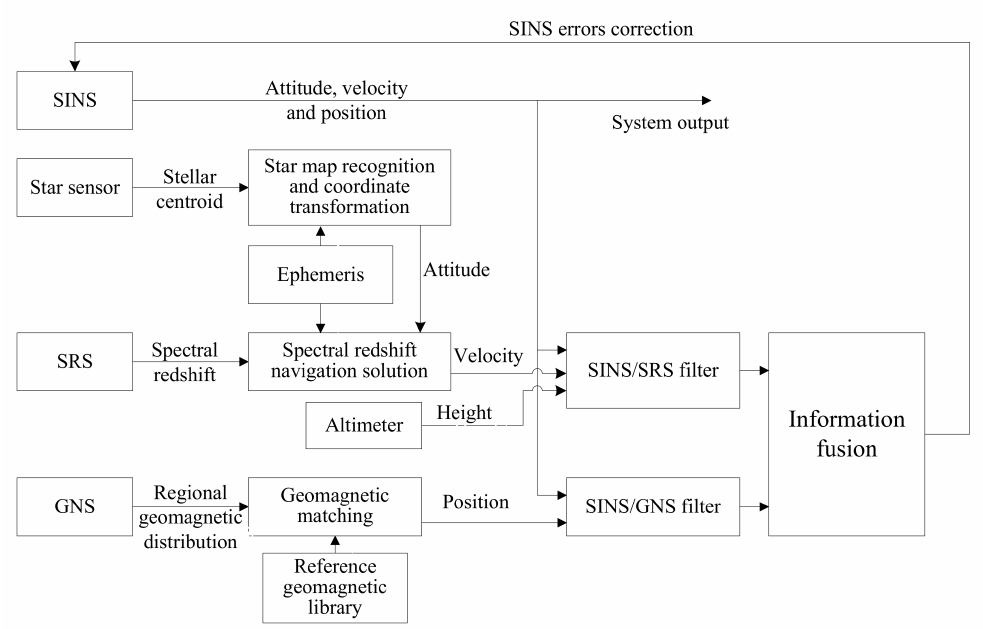
Figure 1. The principle of the SINS/SRS/GNS autonomous integrated navigation